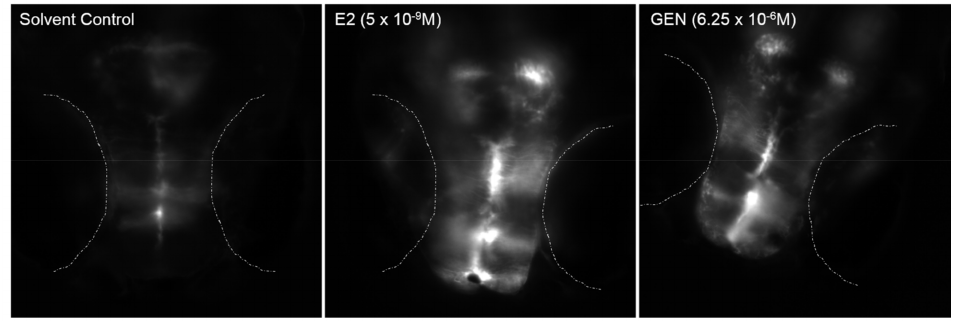
Figure 3. In vivo imaging of transgenic cyp19a1b -GFP zebrafish embryos (4-dpf old) exposed to solvent (DMSO), estradiol (E2) or genistein (GEN) for 96 h. Dorsal view of the brain showing GFP induction in the radial glial cells. For each chemical, the concentration used is indicated. Dotted lines delimit the